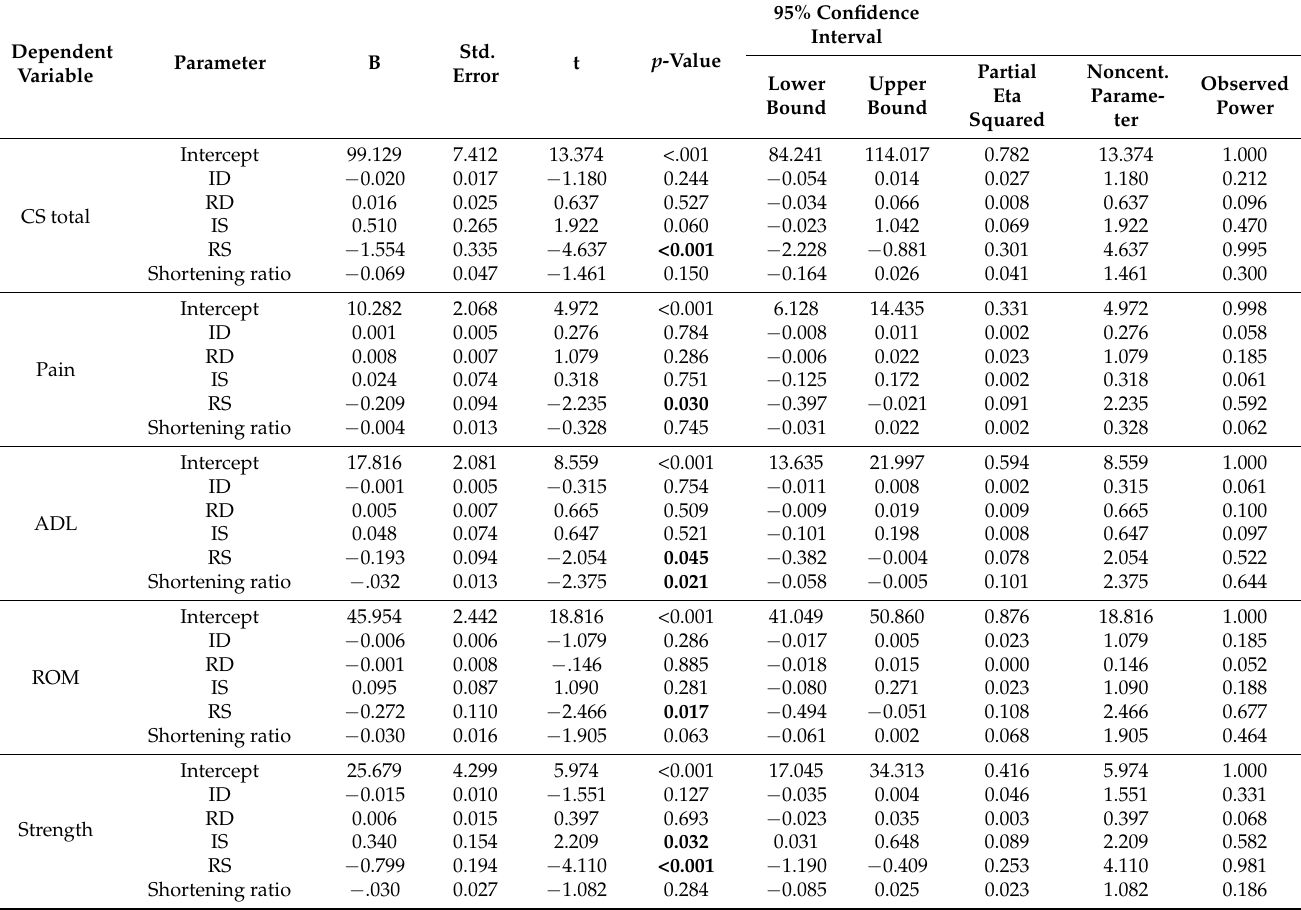
Table 4. Radiological predictors of shoulder function